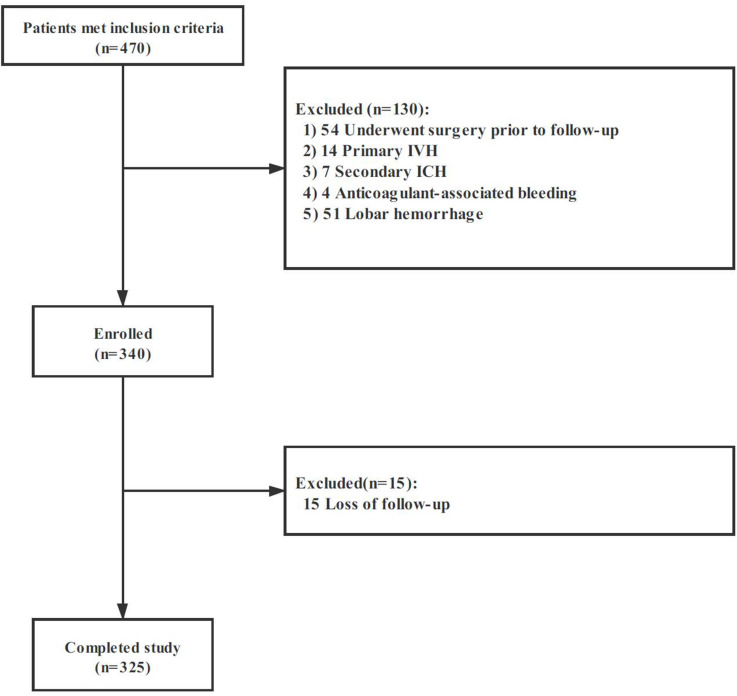
Cohort selection flowchart. Abbreviation: IVH, intraventricular hemorrhage; ICH, intracerebral hemorrhage.